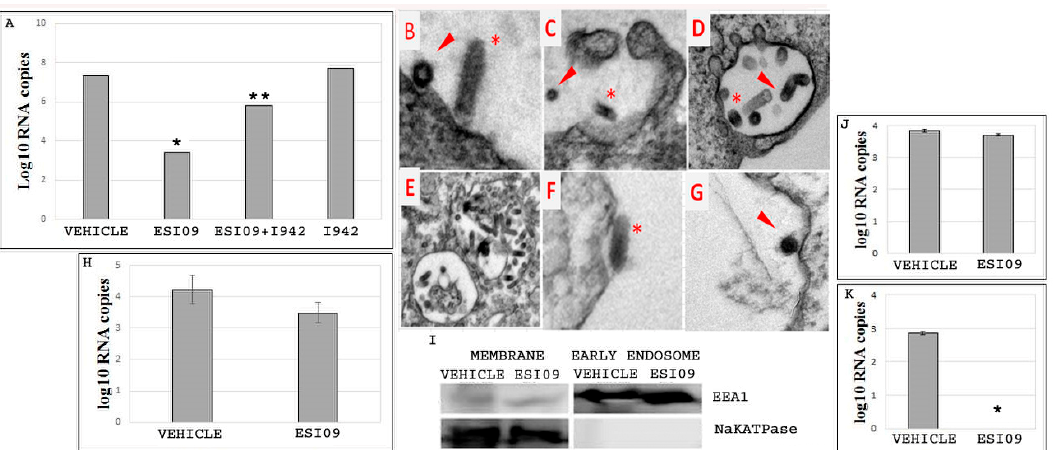
Figure 3. ESI09 blocks the early stage of vesicular stomatitis virus expressing EBOV glycoprotein (EGP-VSV) infection in endothelial cells. ( A ) The number of EGP-VSV viral RNA copies detected at 24 h p.i. in the Vehicle-, ESI09-, ESI09+ I942-, and I942-pretreated HUVECs. N = 3 for each group. * p < 0.05 compared to the Vehicle group, ** p < 0.05 compared to the ESI09 group. ( B – G ) EM detection of EGP-VSV particles in HUVECs pretreated with DMSO ( B – E ) and ESI09 ( F – G ) at 6 h p.i. with EGP-VSV (at an MOI of 200). Arrows highlight EGP-VSV particles in cross-sections, and asterisks indicate particles in longitudinal sections. Scale bar, B – G , 2 µM. ( H ) The number of viral RNA copies detected in the membrane-bound fractions from the binding assay of Vehicle- and ESI09-pretreated HUVECs at 15 min p.i. with EGP-VSV at an MOI of 20. N = 3 for each group. ( I ) Confirmation of the qualities of the samples from the membrane and early endosome fractionations. ( J ) The number of EGP-VSV viral RNA copies detected at 1 h p.i. at an MOI of 200 in the membrane fractions of Vehicle- and ESI09-pretreated HUVECs. N = 3 for each group. ( K ) The number of EGP-VSV viral RNA copies detected at 1 h p.i. at an MOI of 200 in the early endosome fractions of Vehicle- and ESI09-pretreated HUVECs. N = 3 for each group. * p < 0.001 compared to the Vehicle group.